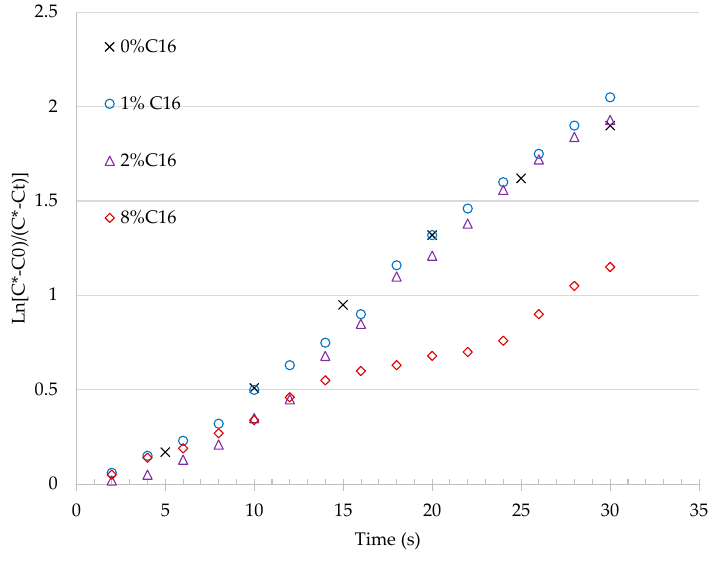
Figure 2. Measurements and correlations (Equation (2)) of oxygen k L a in a mineral solution containing